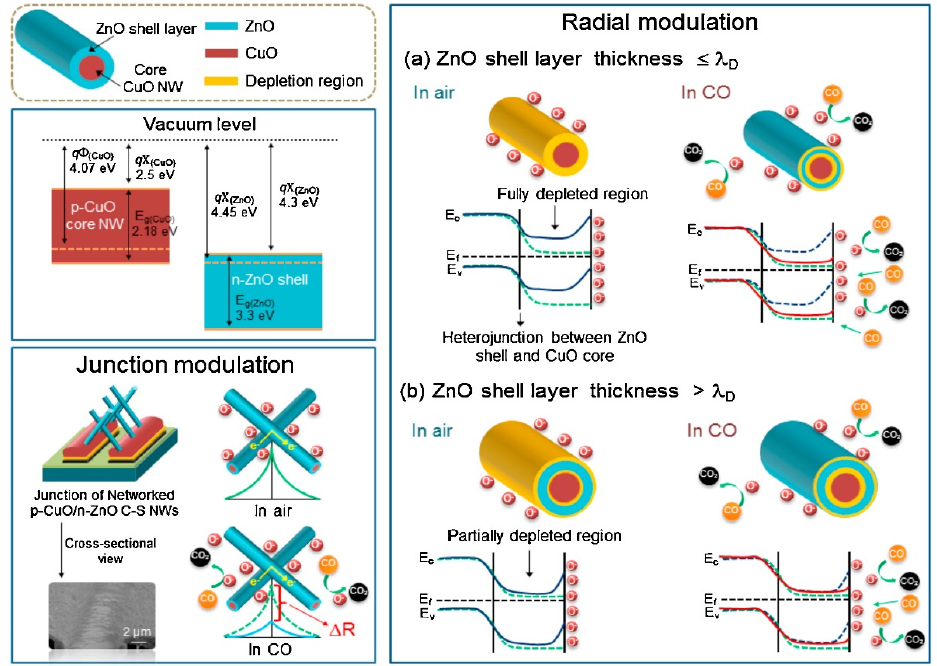
Figure 9. Schematic of the reducing gas sensing mechanism in the CuO–ZnO C–S NWs. Ec and EF indicate the conduction band energy and Fermi energy level, respectively, in cases of ZnO shell layers ( a ) thinner and ( b ) thicker than ZnO’s Debye length. Reprinted with permission from Ref. [136]. Copyright 2016 Elsevier.